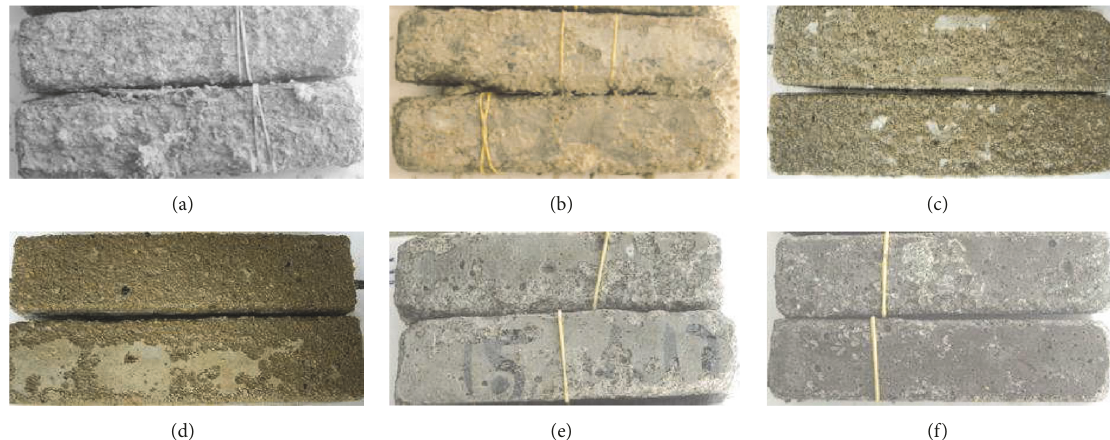
Figure 1: Visual appearance of mortars after 1-year exposure to sulfate: (a) OPC (0.6), (b) SRC, (c) SAC, (d) SAC50, (e) 0.5, and (f) 0.4.